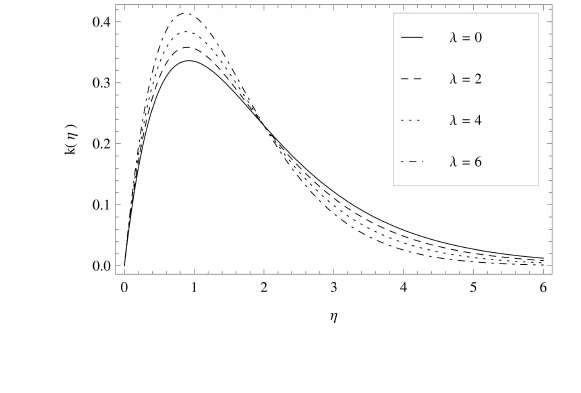
Fig. 14: The influence of a parameter λ on k ( η ) for α = 1, We = 2, M = 0.01, f = 0.01 and (cid:126) = −0.01 w